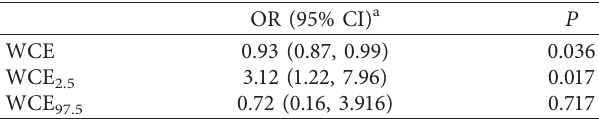
Table 3: Univariate logistic regression of predictors for stroke. Table 4: Multiple logistic regression of the relation between WCE and stroke